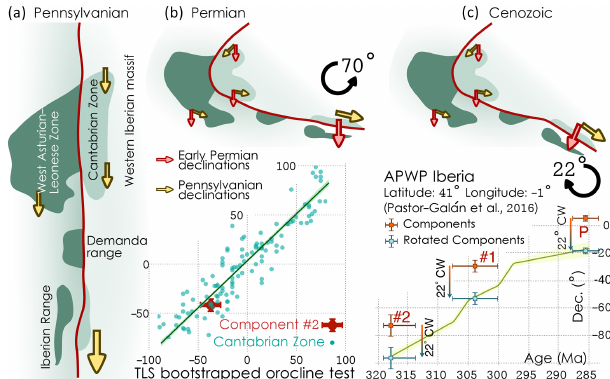
Figure 8. Cartoon depicting the different vertical-axis rotation events that occurred in the Cantabrian Zone and the Iberian Range, modified from Pastor-Galán et al. (2018). (a) Original quasilin- ear Variscan Orogenic belt, (b) formation of the Cantabrian Oro- cline around the Carboniferous–Permian boundary after a ∼ 70 ◦ counterclockwise rotation in the southern branch of the Cantabrian Zone and the Iberian Range. This rotation matches the rotation for the Cantabrian Orocline; see the fit of the Iberian Range Component #2 in the orocline test for the Cantabrian Zone (be- low). (c) Post-Permian (Cenozoic) rotation of ∼ 22 ◦ clockwise (CW) likely produced by differential shortening during the Alpine orogeny (Izquierdo-Llavall et al., 2018). Below, the global magnetic polarity timescale for the Pennsylvanian and Cisuralian (following Ogg et al., 2016). TLS signifies total least squares. Note that once the 22 ◦ CW rotation in the Iberian Range is corrected, components #2, #1, and P fit as expected with the APWP for the southern limb of the Cantabrian Orocline (Pastor-Galán et al.,